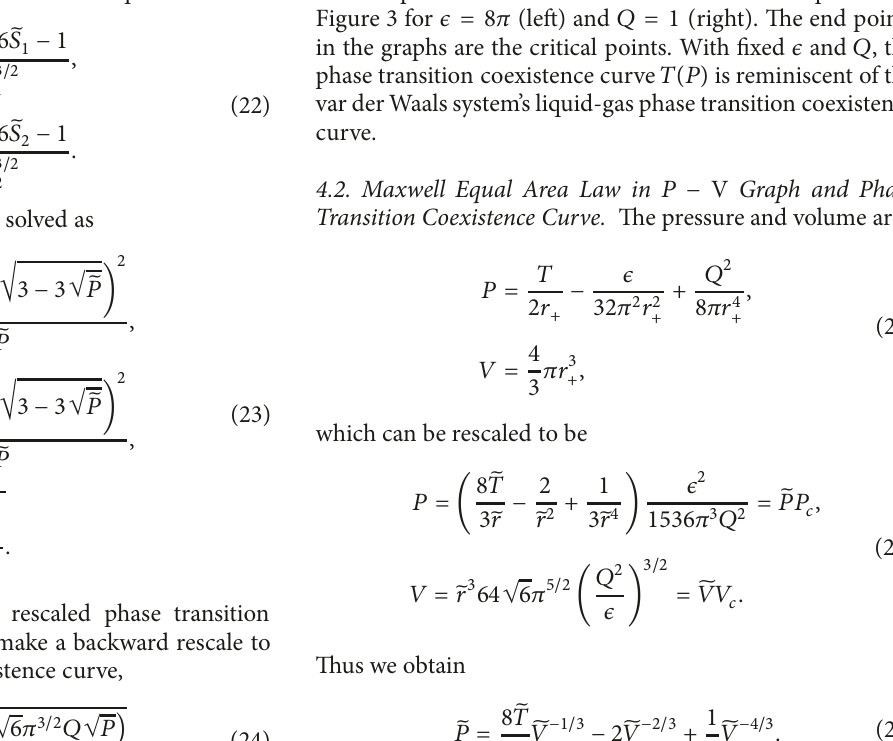
(̃𝑆 , ̃𝑇 ∗ ) and (̃𝑆 , ̃𝑇 ∗ ) , we have two equations The phase transition coexistence curves are plotted in At points 1 2